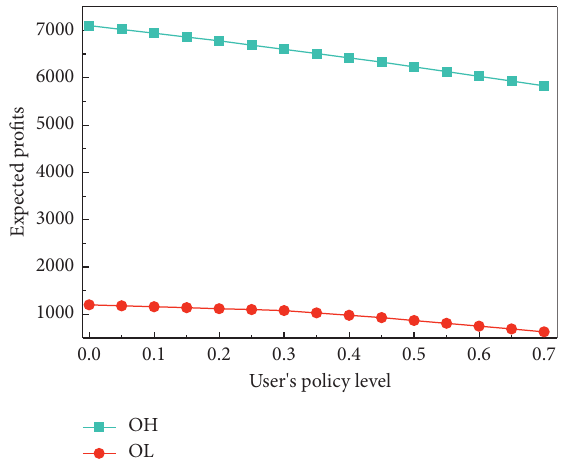
Figure 9: Impact of user policy levels on